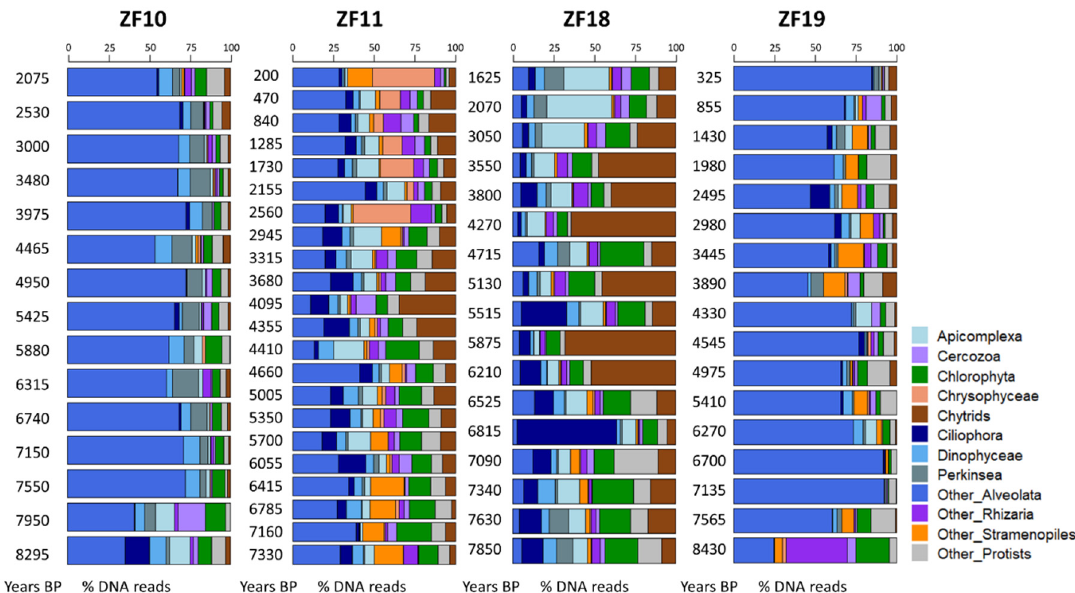
Figure 3. Bar plots showing the temporal changes in the relative abundance of the microbial eukaryotic groups for each lake. For each molecular inventory, the sum of DNA reads for the 12 groups is set to 100%. BP: before present.